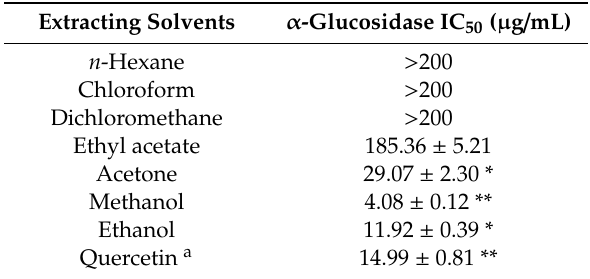
Table 3. α -Glucosidase inhibitory activities of di ff erent solvent extracts.